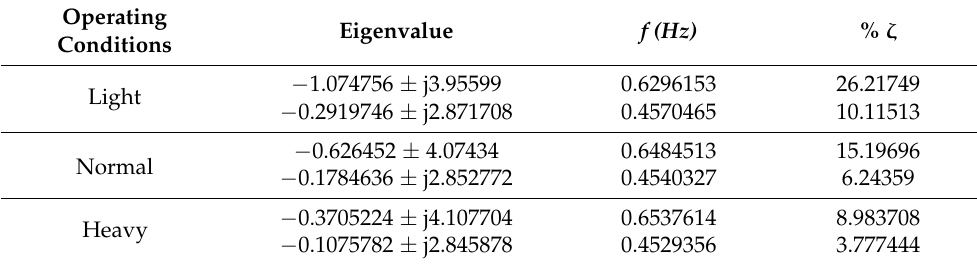
Table 13. Close-loop inter-area modes ϕ -based with